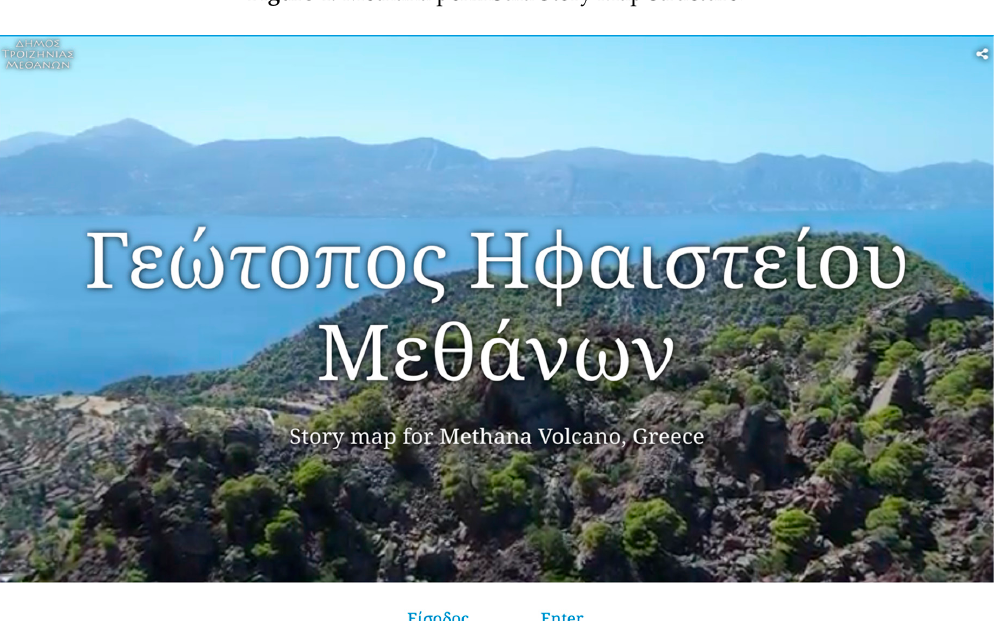
Figure 5. Screenshot presenting the Home page of Story Map for Methana Volcano, Greece (https://goo.gl/ok1j9F).